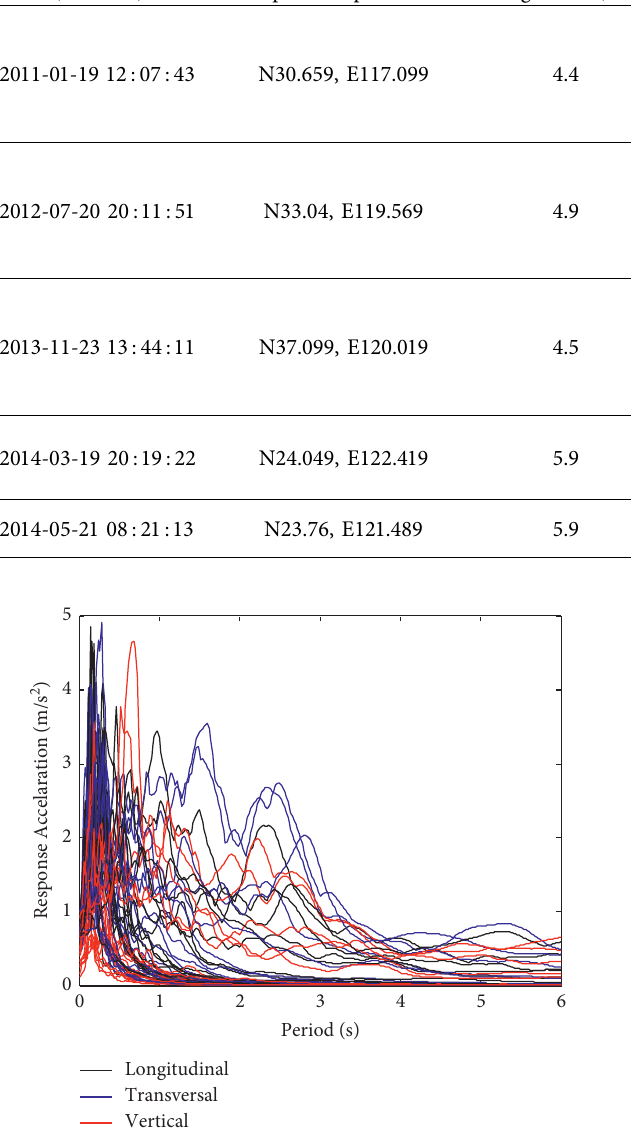
Figure 5: Seismic response spectra of the twenty seismic